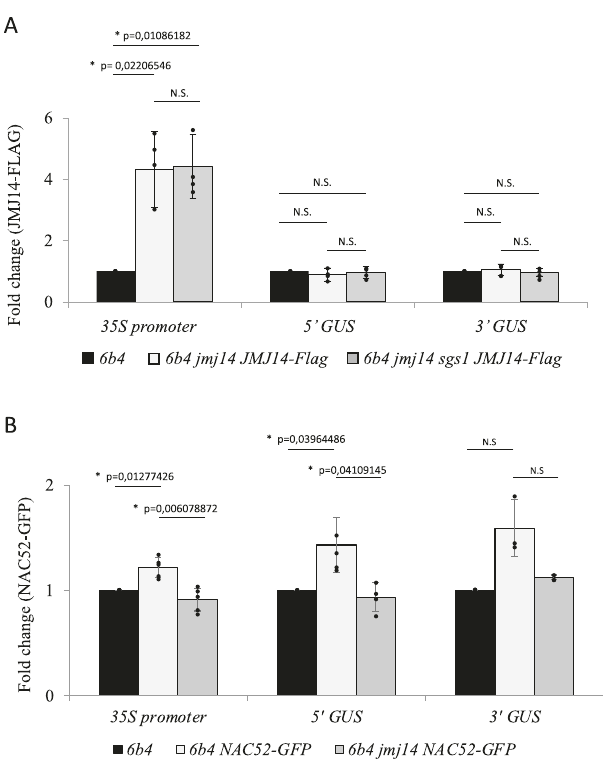
Fig. 7 Hierarchical binding of JMJ14 and NAC52 to the promoter and coding sequence of the p35S:GUS transgene, respectively. A ChIP-qPCR analyses were performed on the aerial part of 17-day-old seedlings of the indicated genotypes using a Flag antibody to immunoprecipitate JMJ14- Flag. Levels are given as percentages of IP sample /IP 6b4 relative to GAPDH, which was used as a control. The graphical representation shows the fold change as the mean of four replicates. Error bars represent the standard deviation of these four replicates. The signi fi cance was assayed with a Bonferroni corrected two-sides t -test ( P < 0.05). Results indicate a relative enrichment of JMJ14 on the 35S promoter of the 6b4 locus, which was not affected by the sgs1 mutation impairing NAC52. B ChIP-qPCR analyses were performed on the aerial part of 17-day-old seedlings of the indicated genotypes using a GFP antibody to immunoprecipitate NAC52-GFP. Levels are given as percentages of IP sample /IP 6b4 relative to GAPDH, which was used as a control. The graphical representation shows the fold change as the mean of fi ve replicates. Error bars represent the standard deviation of these fi ve replicates. The signi fi cance was assayed with a Bonferroni corrected two-sides t -test ( P < 0,05). Results indicate a relative enrichment of NAC52 on the 35S promoter and the beginning of the GUS coding sequence of the 6b4 locus, which was abolished by the jmj14 mutation, indicating a hierarchical action of JMJ14 and NAC52 at the 6b4